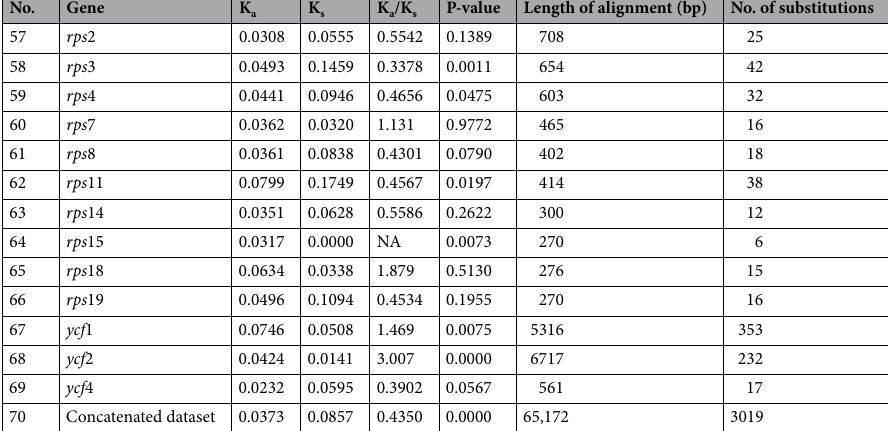
Table 3. Selection pressure analysis of 69 shared protein-coding gene sequences for Aquilaria sinensis (GenBank accession MN720647) and Wikstroemia capitata , analysed separately and combined. NA not